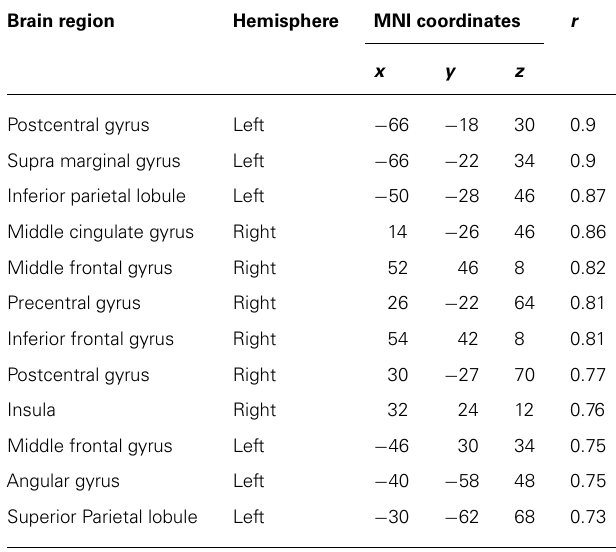
Table 3 | Coordinates of significant correlation coefficients between decoding accuracy and strength of IC during real movements. Brain region